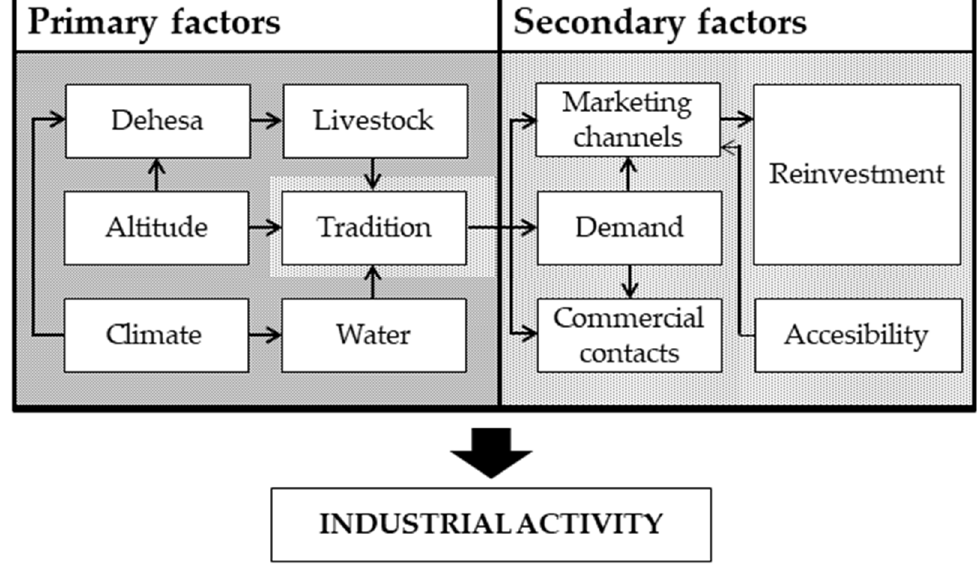
Figure 3. Primary and secondary factors of the IPTI. Source: [61] (p. 126).